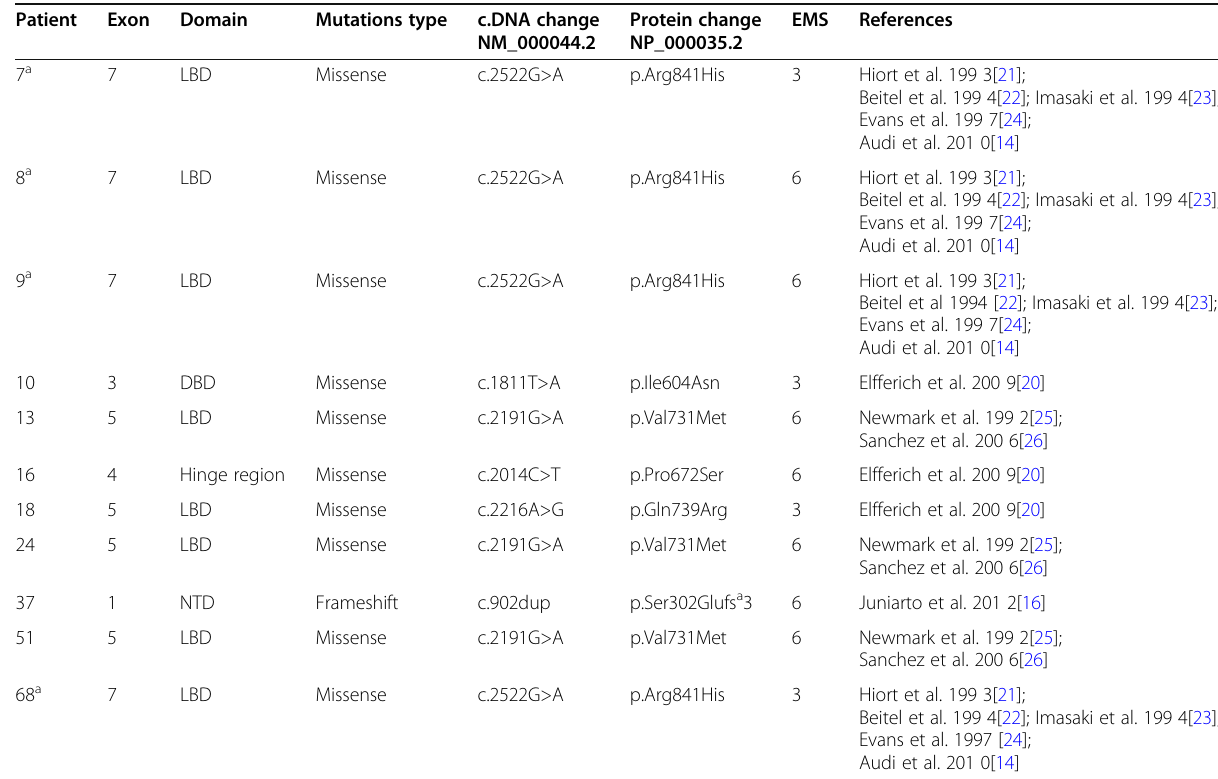
Table 2 Patients carrying AR gene pathogenic variants